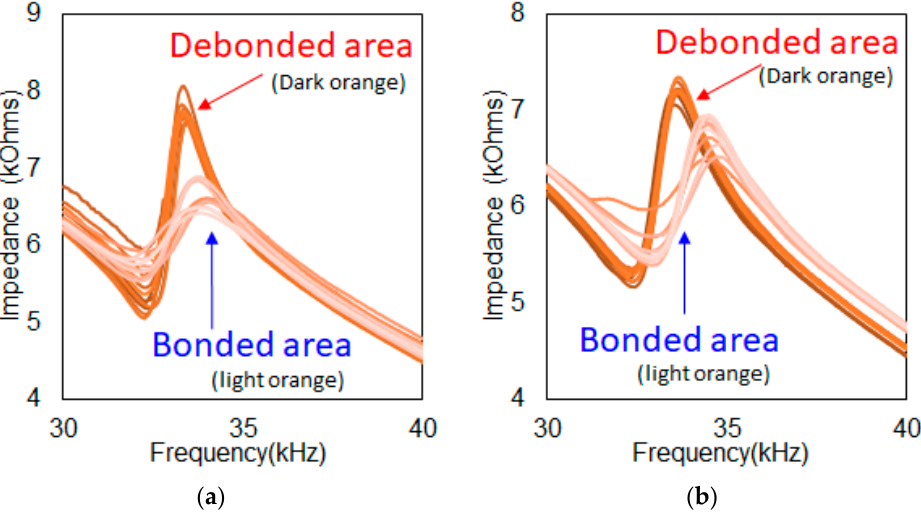
Figure 3. Impedance signatures measured from bonded and debonded areas using the re-attachable device for ( a ) 0.2 mm top plate; ( b ) 0.4 mm top plate.